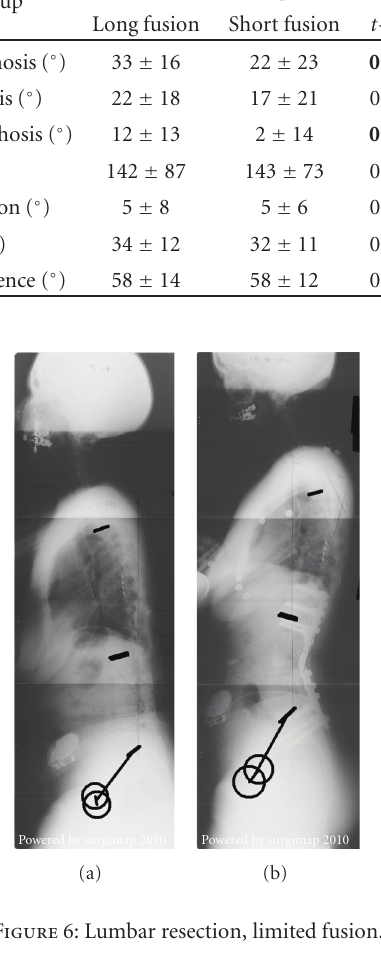
Table 2: Comparison lumbar group—patients that had lumbar PSO. Preoperative and postoperative measurements, P < 0.05 in bold. Pre-Op Post-Op Change Lumbar group Long fusion Short fusion t -test Long fusion Short fusion t -test Long fusion Short fusion t -test